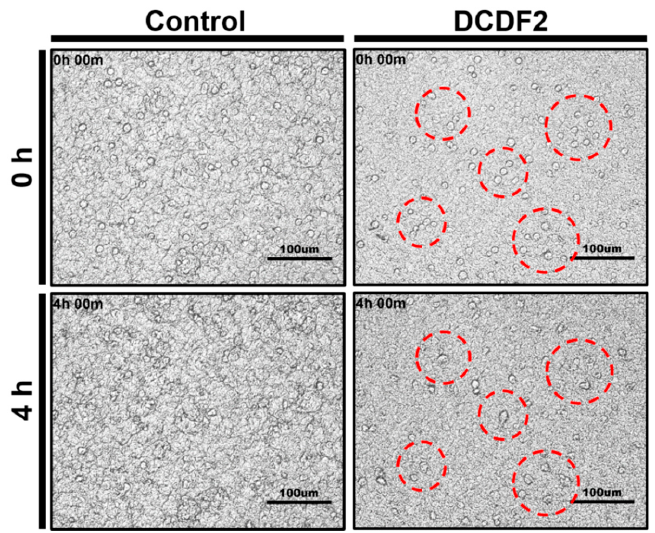
Figure 7. The morphology of neural stem cells (NSCs) seeded on DCDFs examined using time-lapse recording after pre-incubation for 3 h. NSCs were seeded in 12-well plates (4 × 10 5 NSCs per well) coated with DCDFs or the control group. The NSCs on DCDFs had obvious aggregation behavior after 4 h, indicated by red circles. Data were obtained from DCDF2. Control group: thin films without